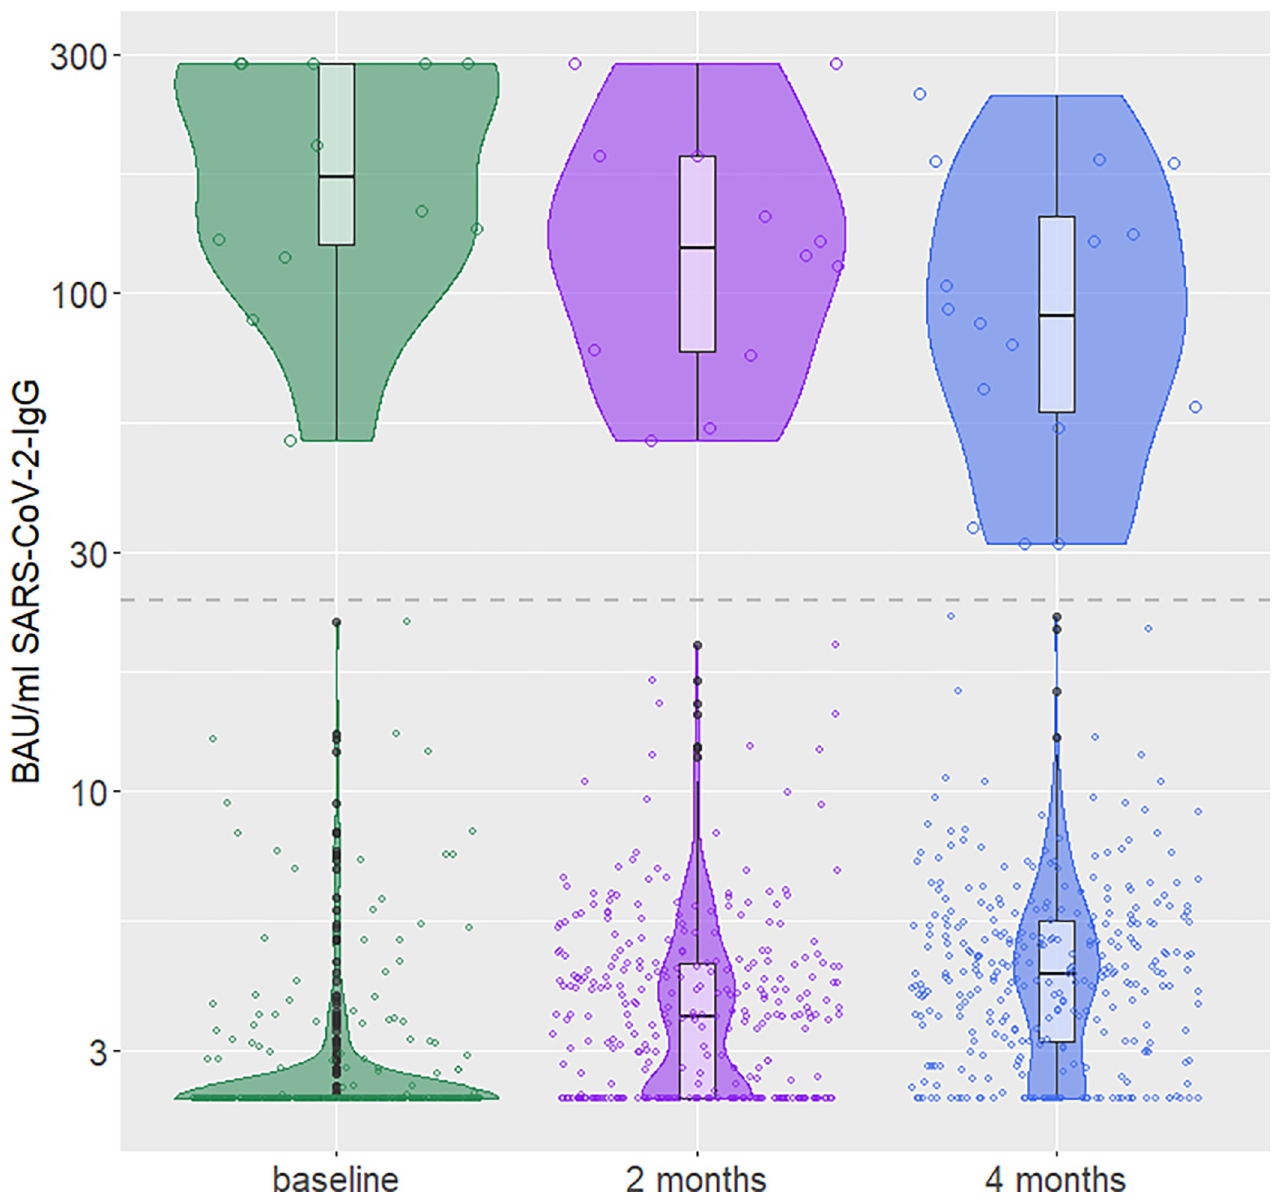
Fig 4. Violinplot SARS-CoV-2-IgG antibodies in BAU/ml over 4 months (dried blood spot: Euroimmun 1 ELISA) (n = 332). The Figure comes log10-scaled on the y-axis. Each violin presents one examination time point, stratified for positive and negative IgG antibody results. The grey dashed line at y = 24.0 BAU/ml indicates the threshold between IgG-positive and IgG-negative results (a test result is IgG-positive at a level of � 24.0 BAU/ml, and negative at a level of < 24.0 BAU/ml).